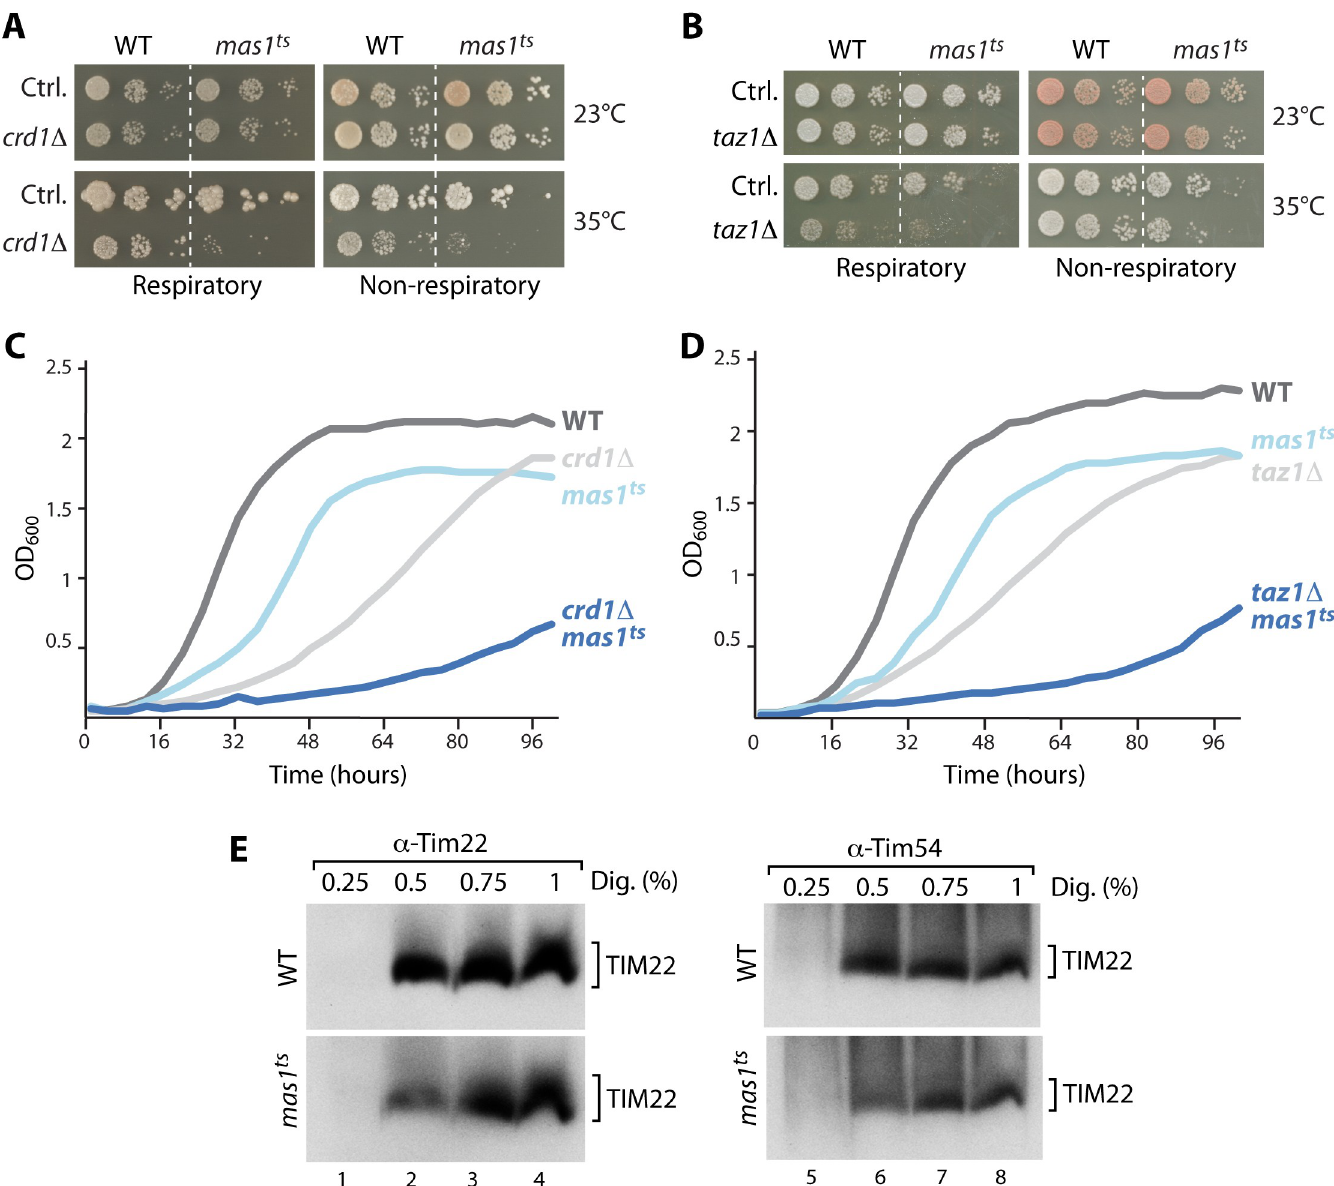
Fig 3. Cellular growth and translocase extractability depend on CL modulation. (A) and (B) Growth assay to test for synthetic effects of CRD1 or TAZ1 deletion in wild-type (WT) and mas1 ts cells. Serial dilutions were tested on respiratory (YPglycerol) and non-respiratory (YPglucose) plates and incubated at 23˚C or 35˚C, respectively. (C) and (D) Growth curves of indicated yeast cells on respiratory growth medium (YPglycerol) at 35˚C. (E) Analysis of native protein complexes in WT and mas1 ts mitochondria isolated from cells grown for 4 hours at non-permissive temperature. Samples were solubilized with indicated concentrations of digitonin and analyzed by Blue-native PAGE and immunodecoration. TIM22, translocase of the inner mitochondrial membrane.